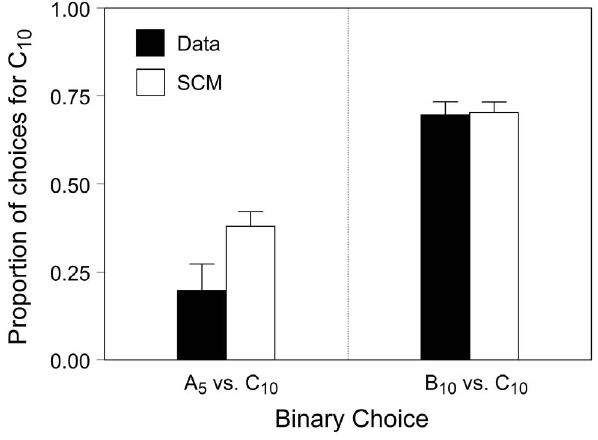
Figure 4. Observed and predicted proportion of choices for option C 10 in both preference tests. Black bars represent the observed average preference for C 10 in the A 5 vs. C 10 (left) and B 10 vs. C 10 (right) preference tests. White bars represent the preference for C 10 predicted by the Monte Carlo simulations in the same tests. Error bars represent one SE.